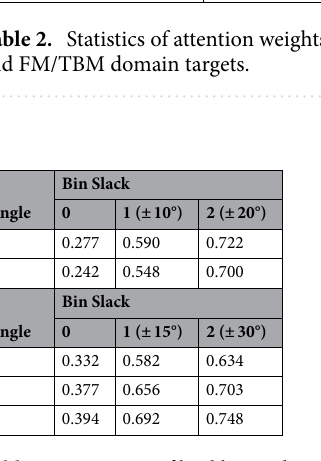
Table 3. Accuracy of backbone phi-psi and orientation angles for the 43 CASP13 FM and FM/TBM domain targets. The bin size of torsional angles was set to 10° while the bin for the orientation angles was 15°. Bin slack of 0 represents that the predicted bin of the highest probability and the real bin were the same. Bin slack of 1(or 2) denotes that the predicted bin was 1(or 2) bin(s) away from the correct bin.